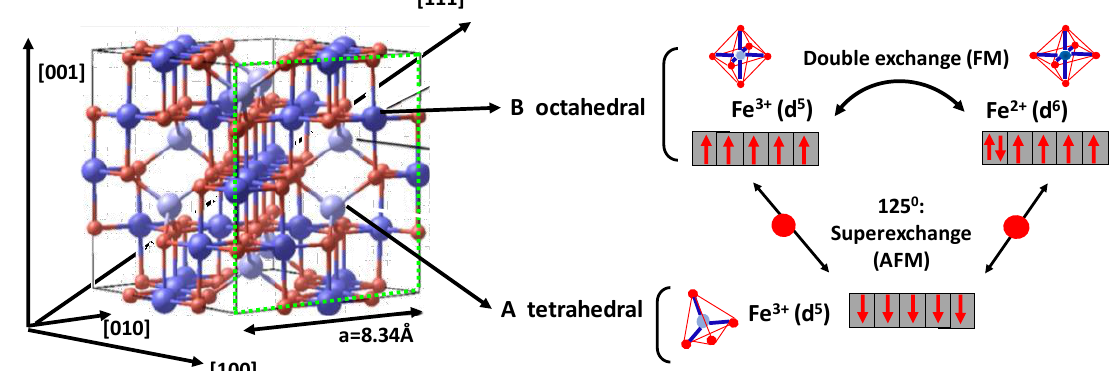
Figure 1. On the left, the inverse spinel structure (crystal structure adapted from [16] (Science Direct, 2016), of Fe 3 O 4 is based on a face centered cubic (fcc) arrangement of O 2 − ions in which Fe 3 + (d 5 ) cations occupy 1 / 2 of the tetrahedral interstices, and a 50:50 mixture of Fe 3 + (d 5 ) and Fe 2 + (d 6 ) cations occupy 1 / 8 of the octahedral interstices. On the right, the set of exchange interactions between Fe 3 + (d 5 ), Fe 2 + (d 6 ) and O 2 − ions, giving rise to ferrimagnetic ordering.